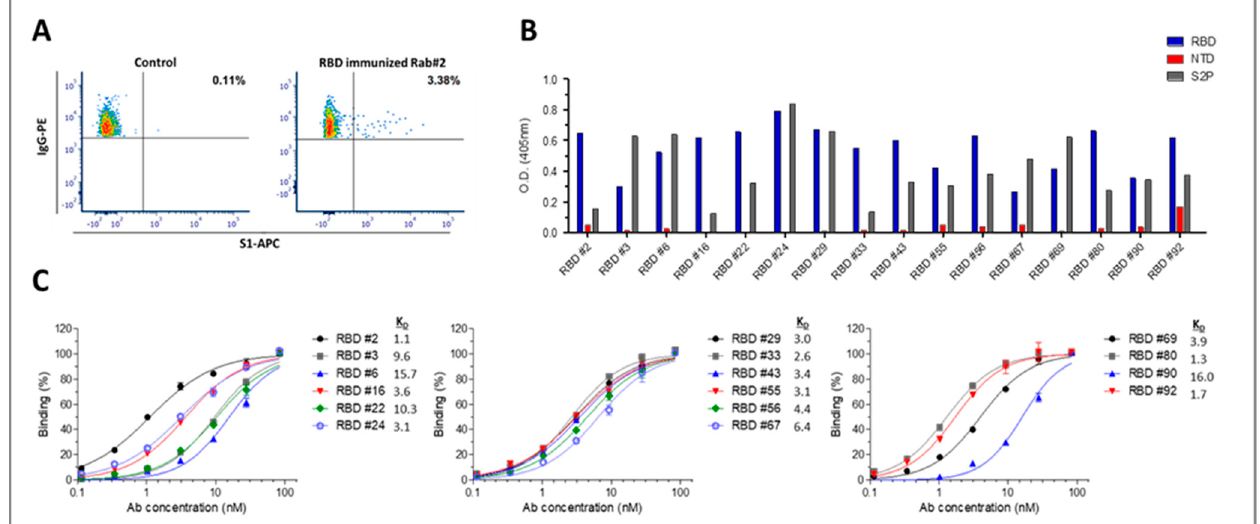
Figure 4. Isolation and characterization of anti-RBD antibodies. ( A ) Splenocytes were isolated from huFc-RBD-immunized rabbit 2 and were analyzed by flow cytometry using anti IgG-PE and APC Figure 1. IgG + /APC-S1 + B cells (located at the upper right quadrant and represented as percent out of total IgG + cells) were single-cell sorted into 96-well microplates by FACSAria. Naïve rabbit PBMCs were analyzed as a negative control, demonstrating the specificity of the sorting strategy. ( B ) Specificity of the anti-RBD antibodies was determined by ELISA against the indicated SARS-CoV-2 proteins. Results are averages of duplicates from a representative experiment (out of two performed with similar results). ( C ) Binding profile of the antibodies determined by ELISA using RBD as the coating antigen. Data are presented as binding percent of B max for each antibody. The values represent average of triplicates ±SEM fitted by non-linear regression. The apparent K D (nM) value of each antibody is shown.